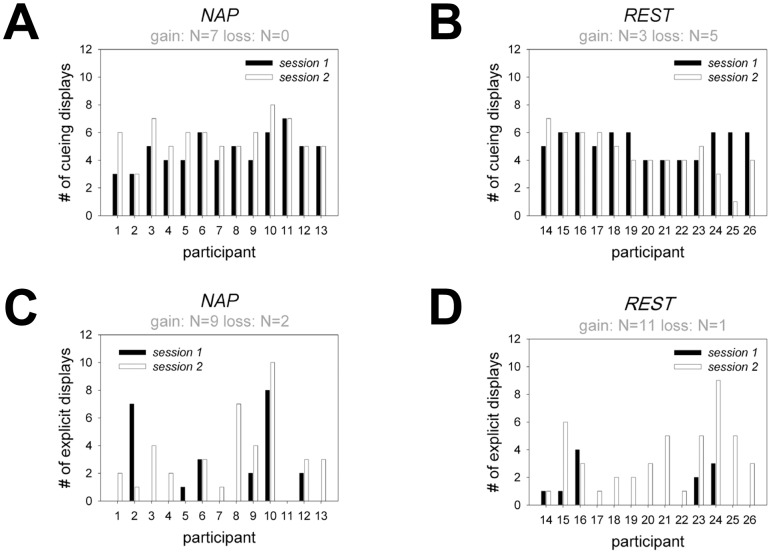
Results from single display analysis.
A–B: Number of repeated displays that generated a contextual cueing effect in the implicit search task for the nap and rest conditions. C–D: Number of repeated displays that yielded recognition in the explicit memory task. The grey values presented at the top of each graph indicate the number of participants that showed increased (“gain”) or decreased (“loss”) memory performance in the respective learning measure.